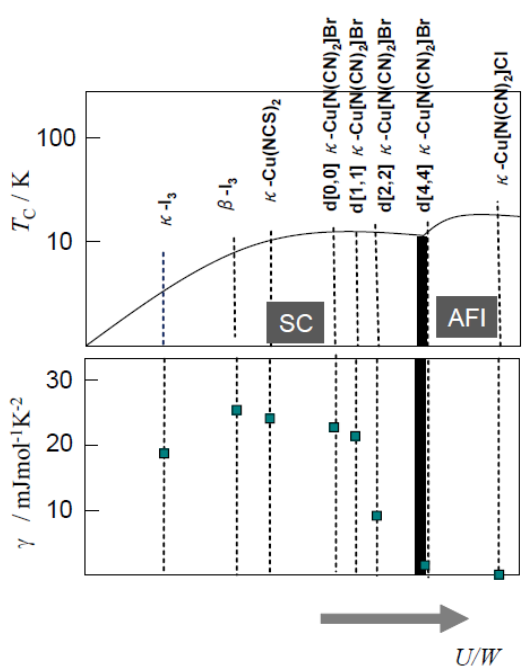
Figure 7. The normal states electronic heat capacity coefficient γ obtained by heat capacity data above H is plotted according to U / W ratio as a c2